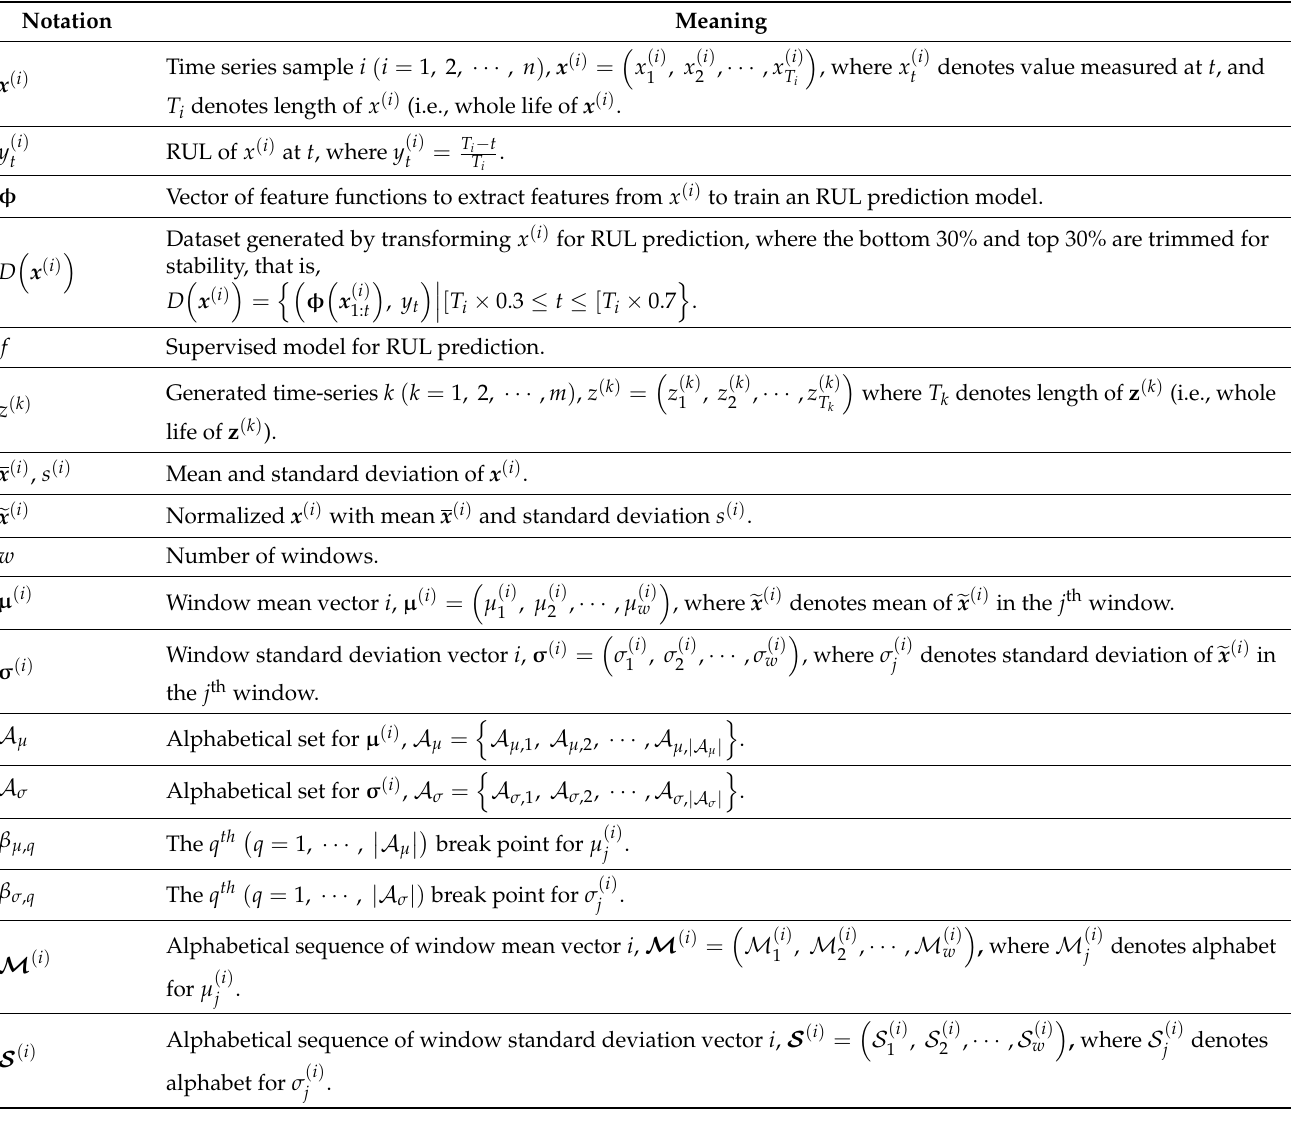
Table 2. Mathematical notations used in this